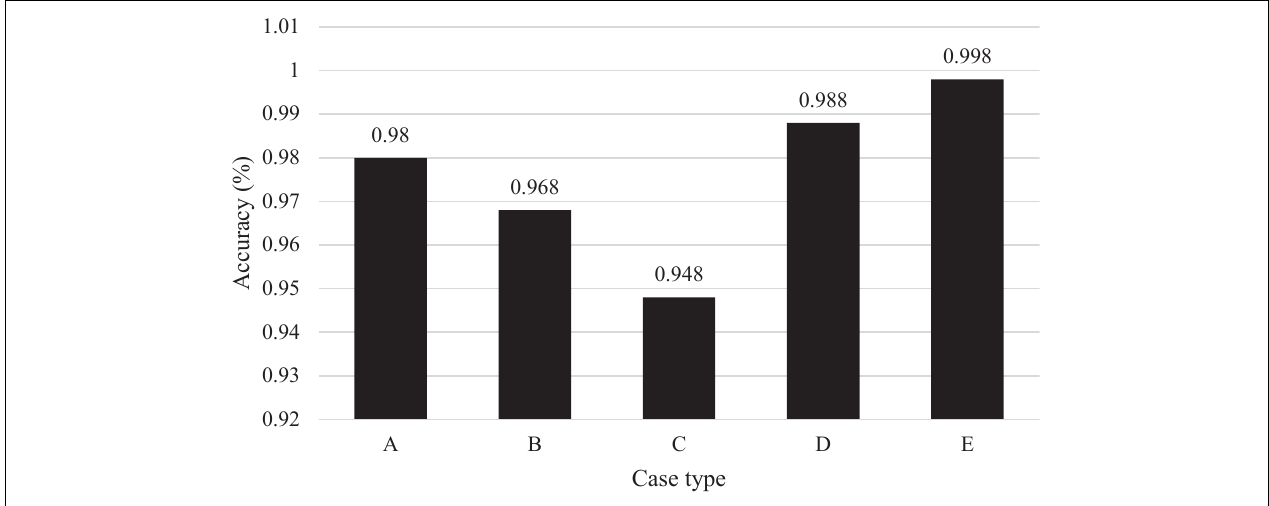
FIGURE 16 | The accuracy of the trial results. (A: Traffic accident infringement; B: copyright infringement; C: trademark infringement; D: copyright protection; E: theft infringement).